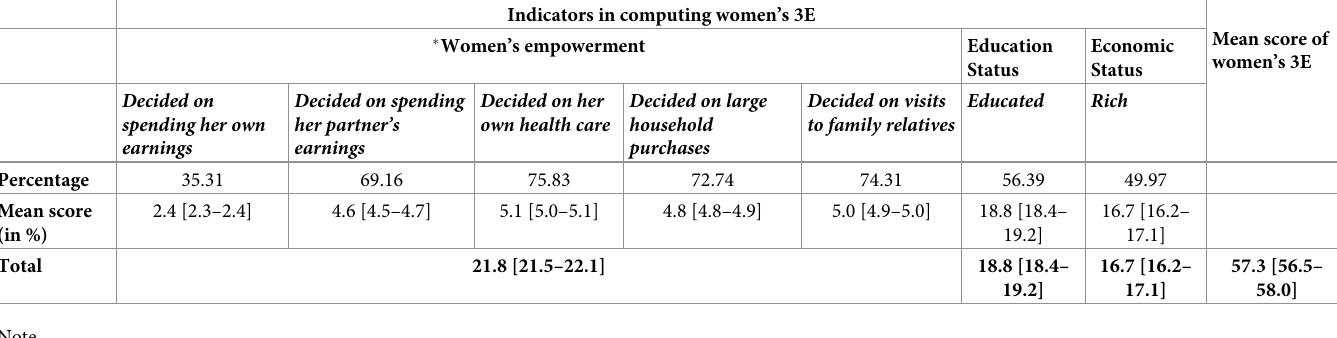
Table 2. Frequency distribution of several indicators of women’s 3E along with its mean score and 95% confidence